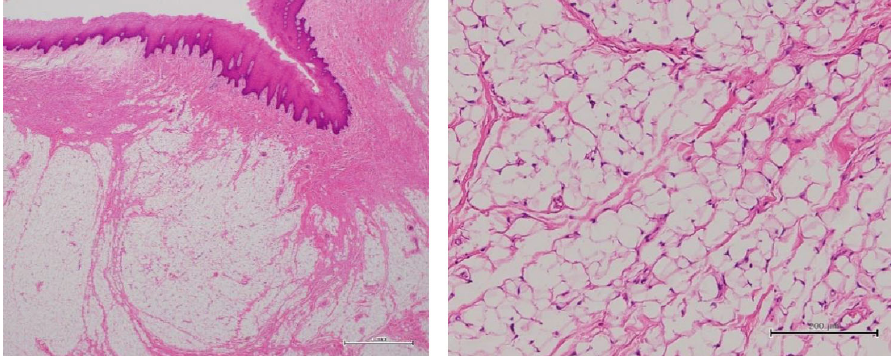
Figure 4: Histological examination. Connective tissue is found under the epidermis, and adipose tissue is fi lled underneath. Mature adipose tissue hyperplasia with blood vessels is noted in high magni fi cation.